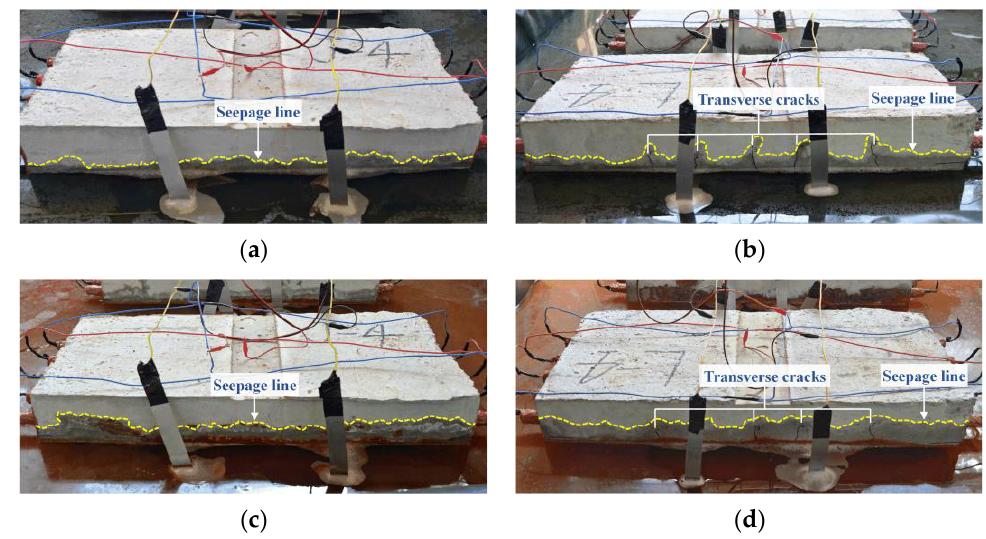
Figure 7. Corrosion procedure: ( a ) intact slab at initial stage; ( b ) pre-cracked slab at initial stage; ( c ) intact slab at middle stage; ( d ) pre-cracked slab at middle stage.